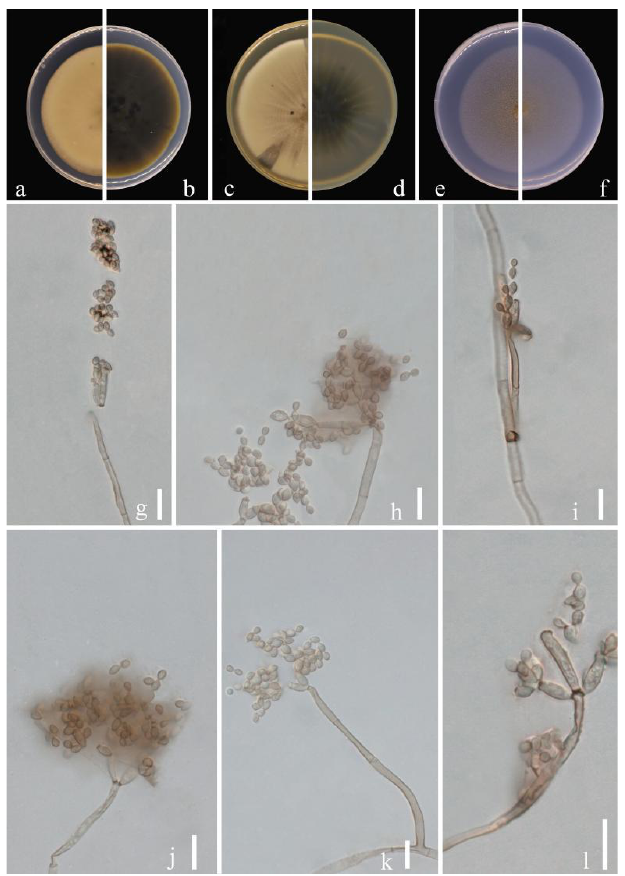
Figure 8. Cladosporium punicae (HGUP 21271, holotype). ( a , b ) Culture on PDA from above and